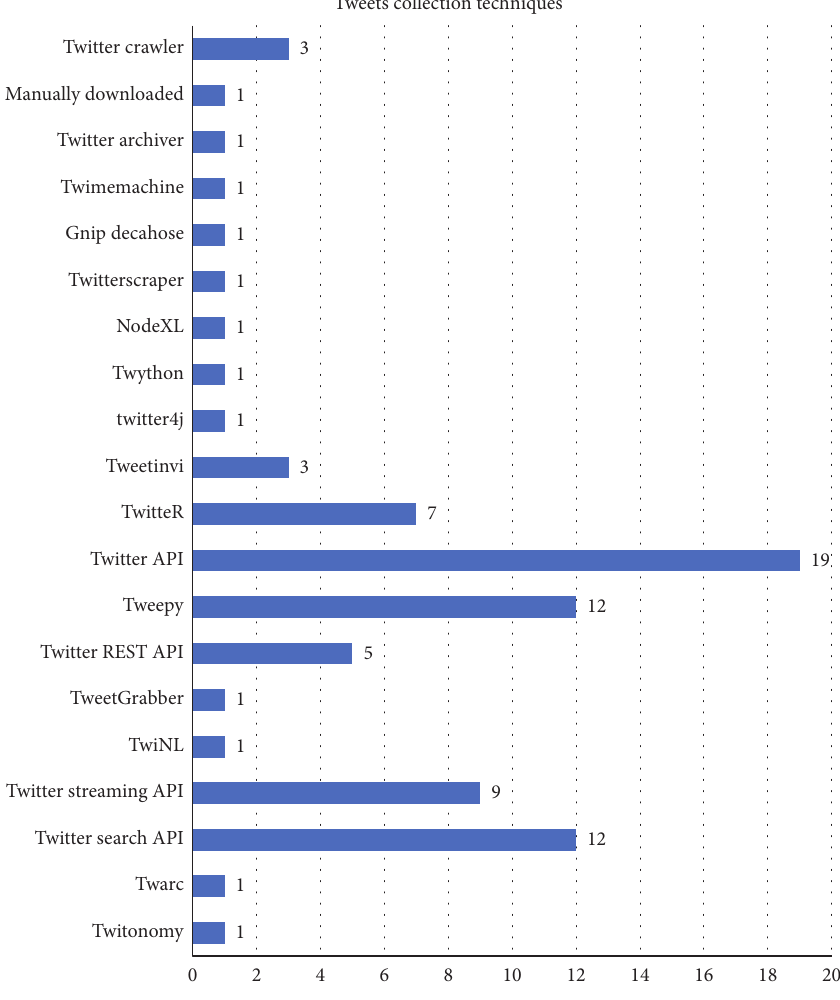
Figure 9: Tweet collection tool/technique distribution over reported studies.